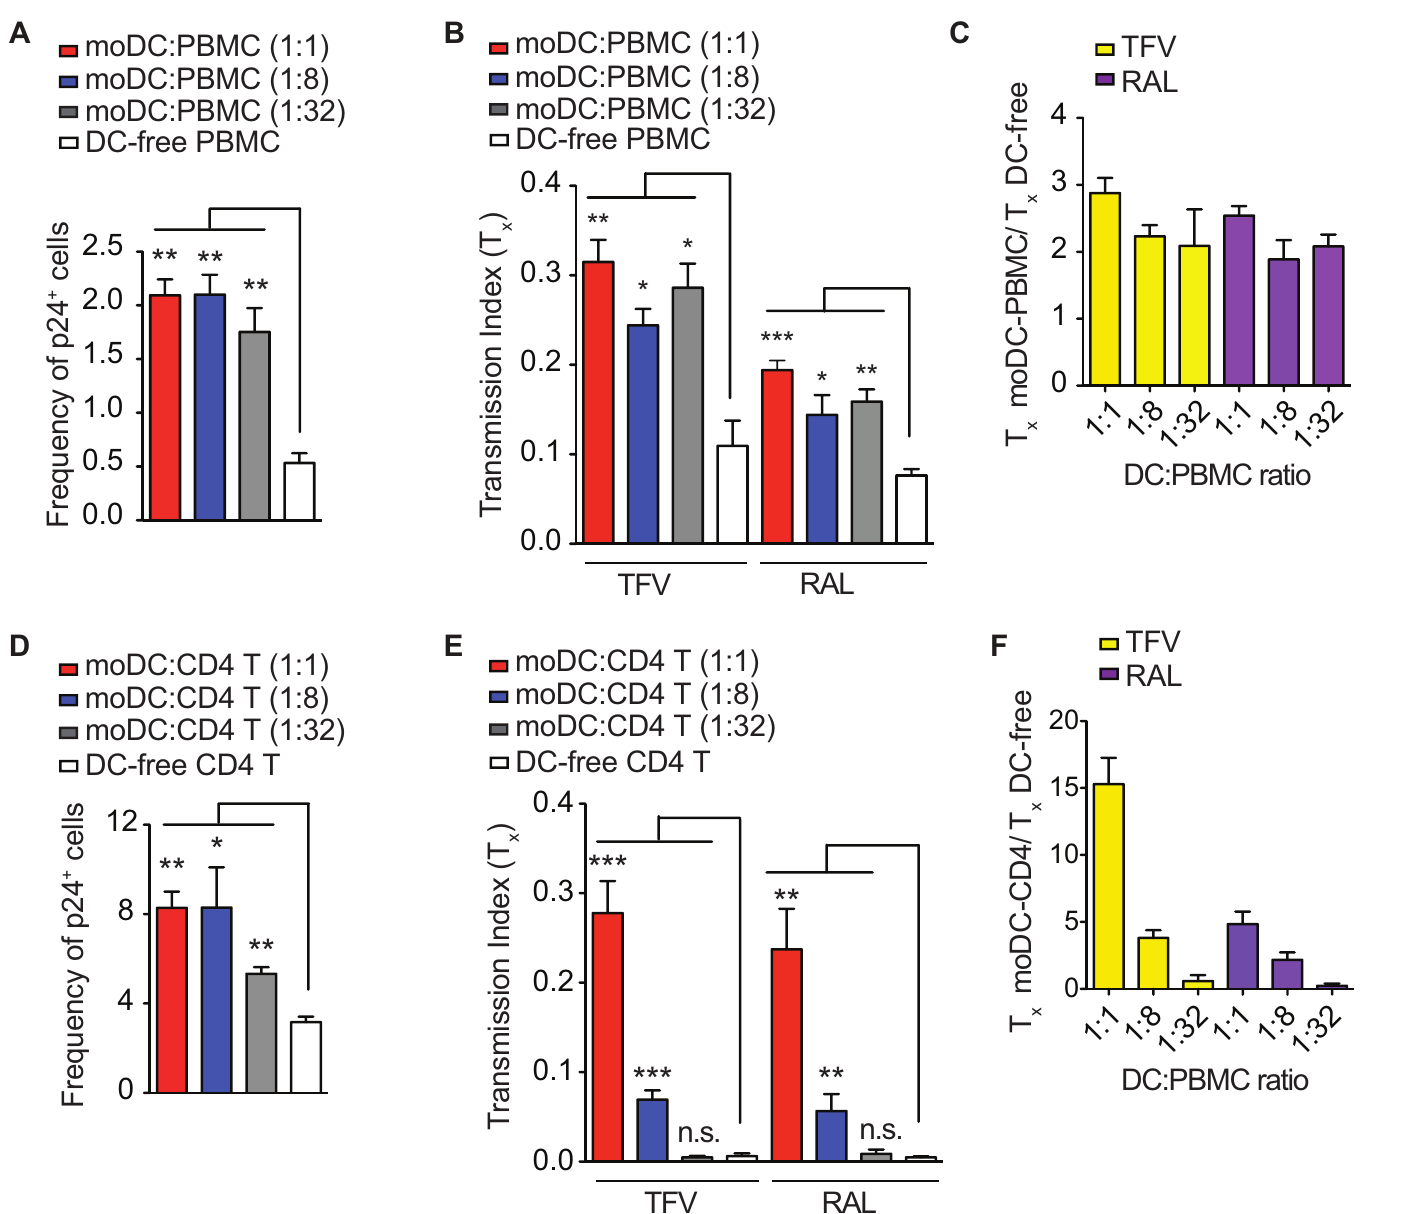
Fig 4. HIV transmission between moDCs and PBMCs or isolated CD4 + T cells is efficient and insensitive to RAL. ( A, D ) The moDCs were cocultured with autologous PBMCs (A) or CD4 + T cells (D) at ratios of 1:1, 1:8, and 1:32. The cultures were infected with NL4-3. The frequency of infected p24 + T cells was measured using flow cytometry. ( B, E ) The moDC-PBMC coculture (B) or moDC-CD4 + T cell coculture (E) or DC-free cultures were infected with NL4-3 in the presence or absence of 10 μM of TFV or 10 μM of RAL and drug insensitivity (T x ) was measured. ( C, F ) Fold differences between the T x values of moDC-PBMC coculture (C) or moDC-CD4 + T cell coculture (F) and DC-free culture were measured. Mean ± s.e.m ( η = 3 technical replicates). (cid:3) , p < 0.05; (cid:3)(cid:3) , p < 0.01, (cid:3)(cid:3)(cid:3) , p < 0.005 (student’s T-test). n. s., p > 0.05. Data is representative of one donor from two independent experiments ( A - F ).